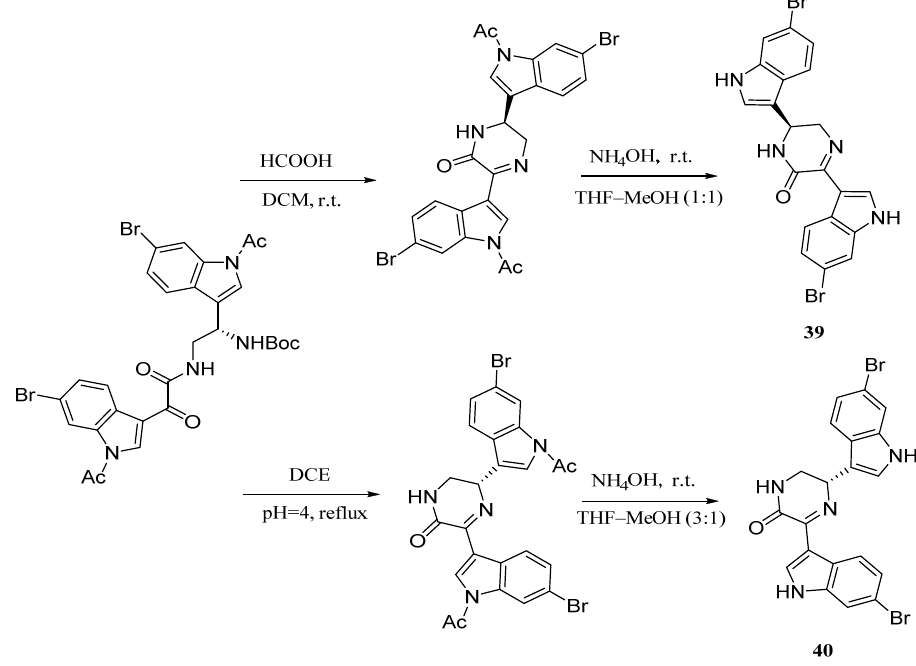
Molecules 2023 , 28 , x FOR PEER Figure 8. Structures of hamacanthin A and hamacanthin B ( 39 , 40 ). Figure 8. Structures of hamacanthin A and hamacanthin B ( 39 , 40 ).